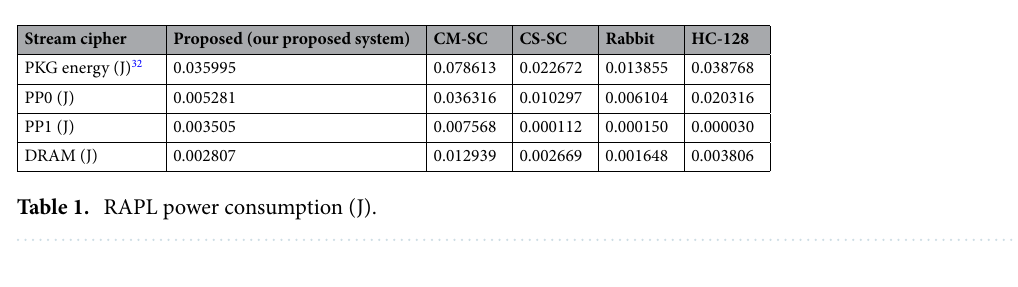
Figure 4. Stream cipher encryption for a plaintext image with it is cipher image 31 .